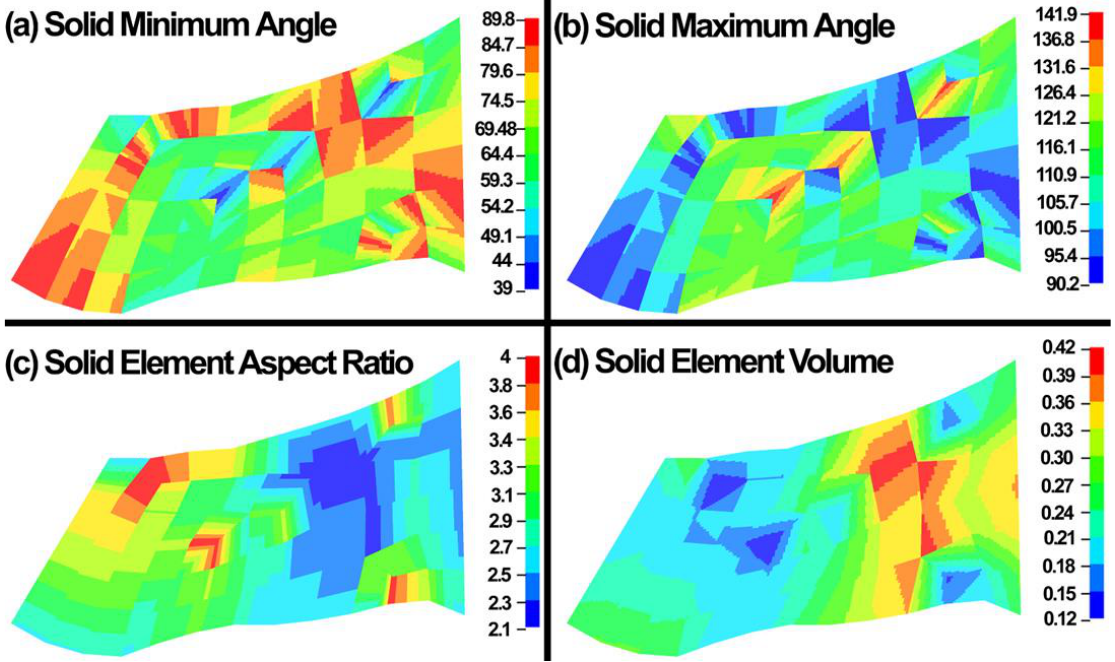
Figure 10. ( a ) Solid minimum angle, ( b ) solid maximum angle, ( c ) solid element aspect ratio, and ( d ) solid element volume (µm 3 ) in the FE model.